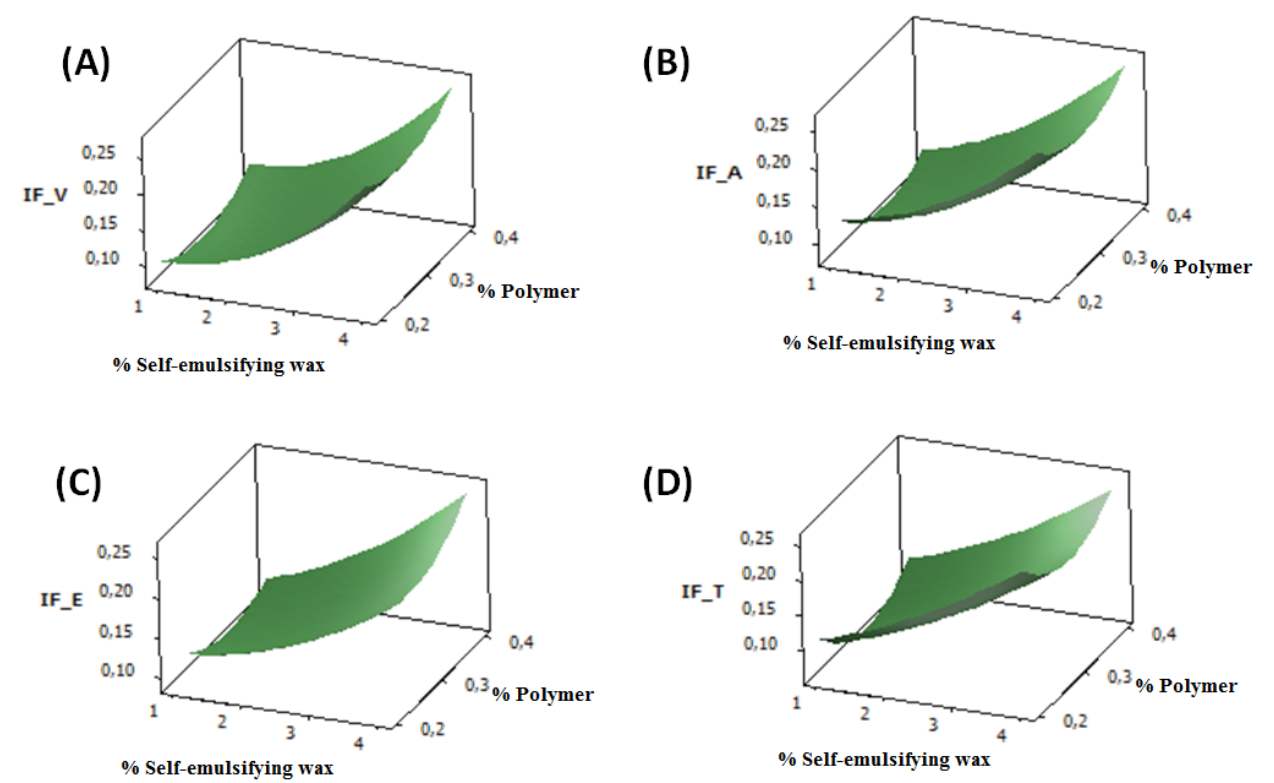
FIGURE 2 - Response surfaces for flow index (IF) as a function of the factors: % of self-emulsifying wax and % hydrophilic polymer for the formulations: vehicle (A) containing 0.5% retinyl palmitate (B), 5% tocopheryl acetate (C) and 0.1% tocoretinate